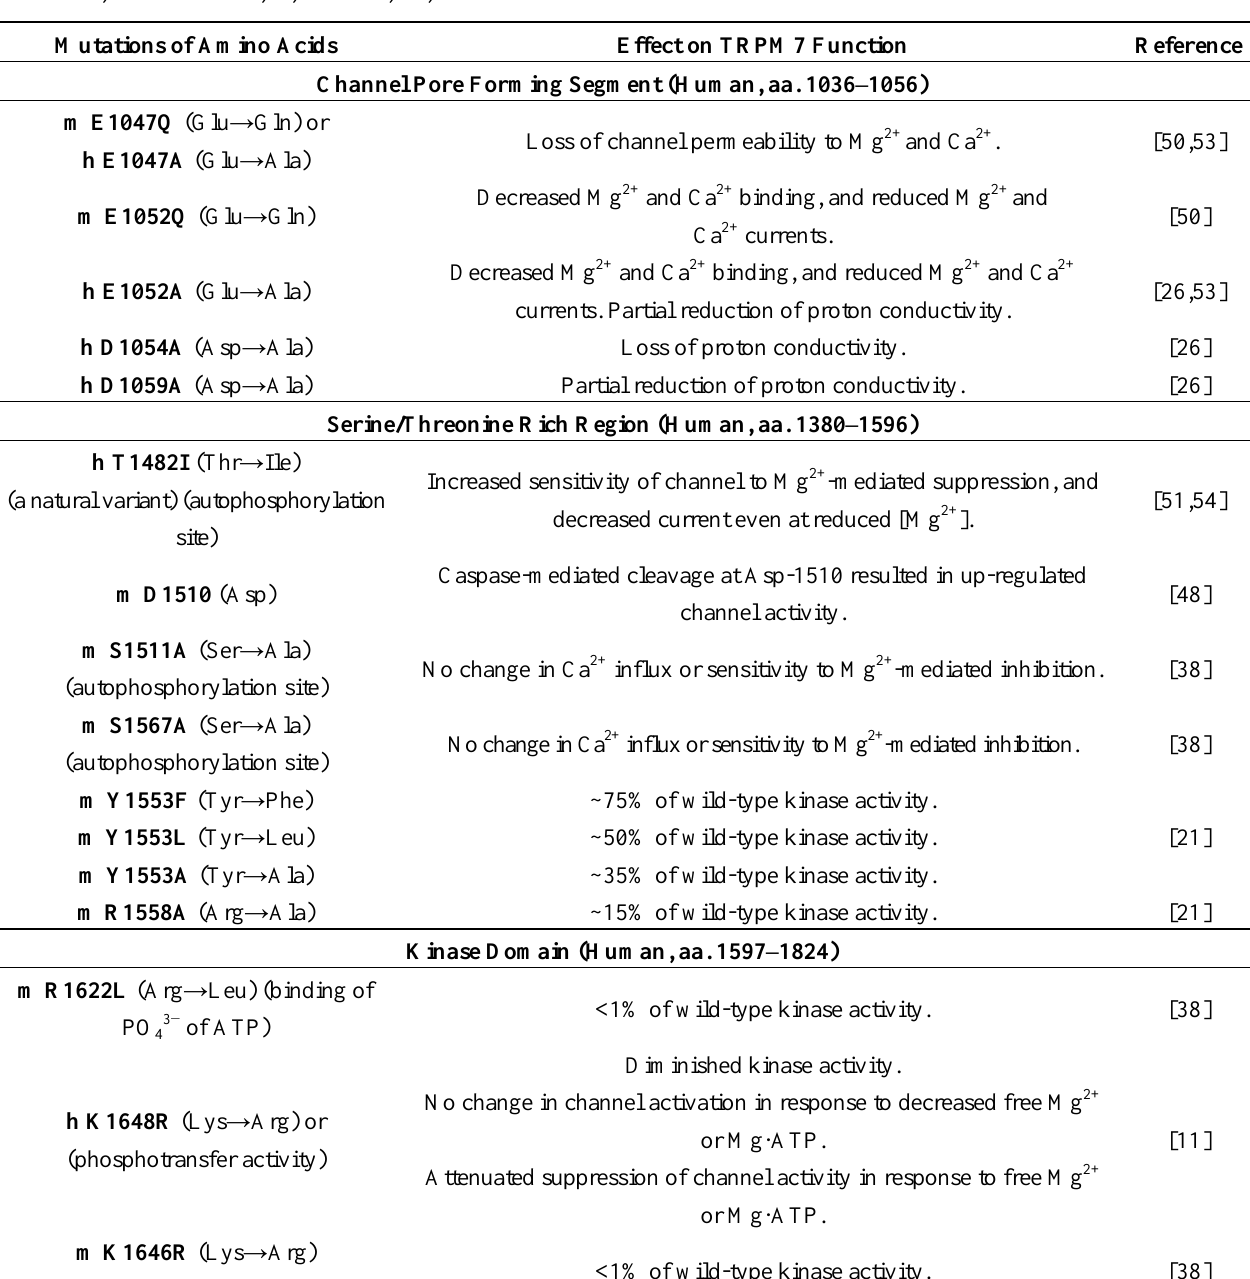
Table 1. Molecular determinants of the functions of TRPM7 channel-kinase. The amino acids and the associated functions as determined by site-directed mutagenesis of TRPM7. aa, amino acids; h, human; m,